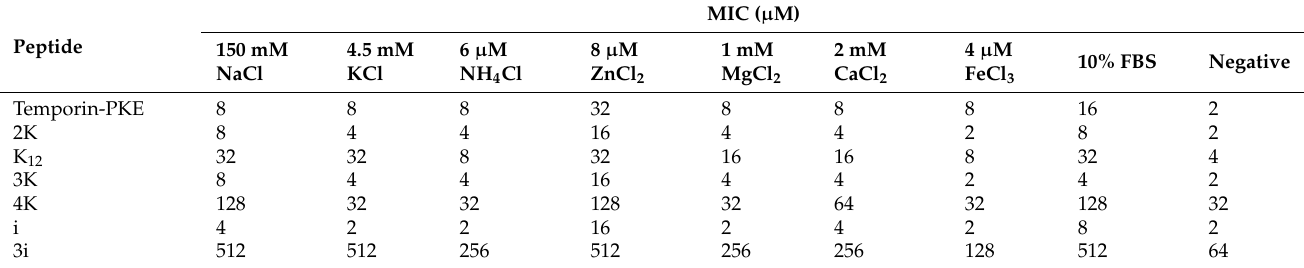
Table 7. The MICs of temporin-PKE and its analogues against MRSA in the presence of various salts and 10%